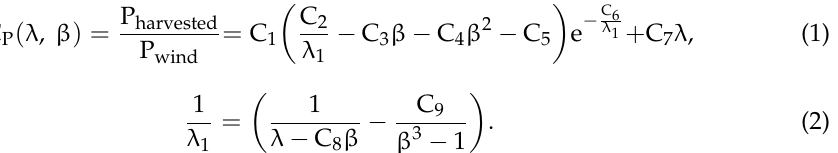
Table 1. Key specifications of the NREL 5 MW [19]. Parameter Value Nominal power 5 MW Hub and rotor diameters 3, 126 m Hub height 90 m Cut-in, nominal, cut-out wind speed 3, 11.4, and 25 m/s Number of blades, rotor topology 3, upwind Rotor, generator nominal speed 12.1, 1173.7 rpm Efficiency 94.4% Control Collective pitch, variable